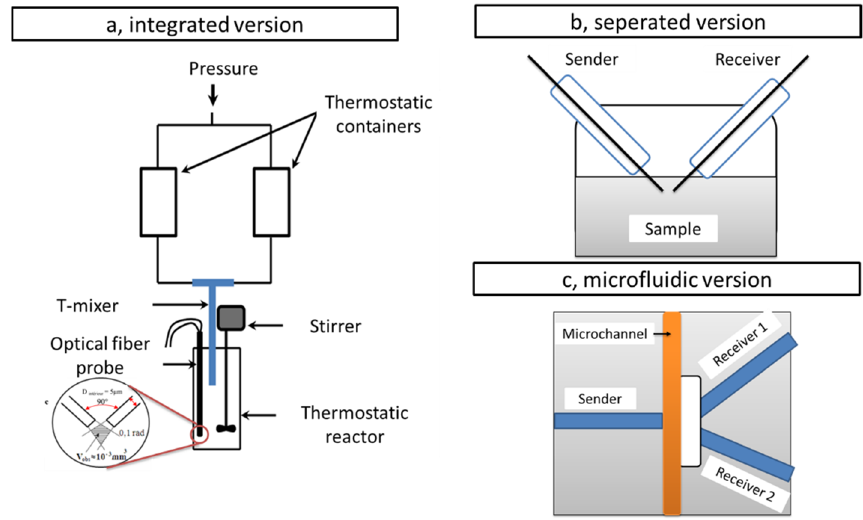
Figure 4. Three common modes of incorporating the optical fiber with existing reactor: ( a ) integrated, ( b ) separated and ( c ) microfluidic chips. (Reprinted/adapted with permission from Refs. [50–52]. Copyright © 2023 Elsevier Ltd. and © 2023 The Institution of Chemical Engineers. Elsevier B.V.). Table 3. The main characteristics of three common reactors which integrate DLS system. Integrated Separated Microfluidics Reference